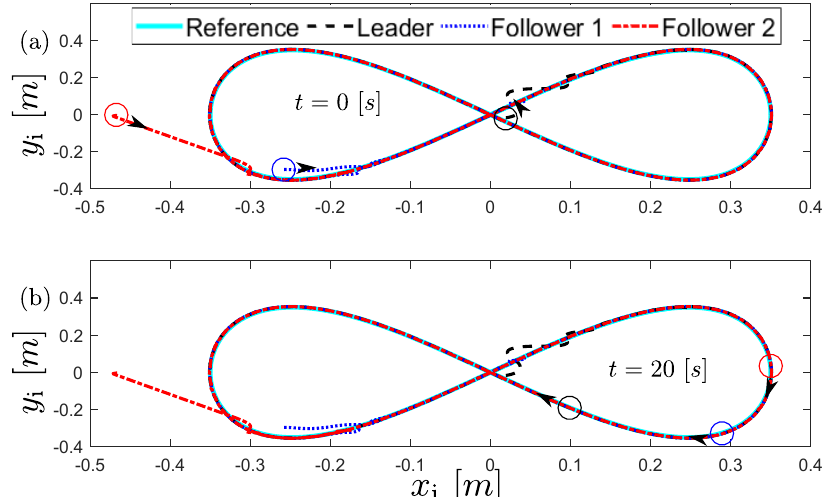
Figure 3. Trajectory of the robot group following the circular path: Robots at the time instants t = 0 and t = 15 s.